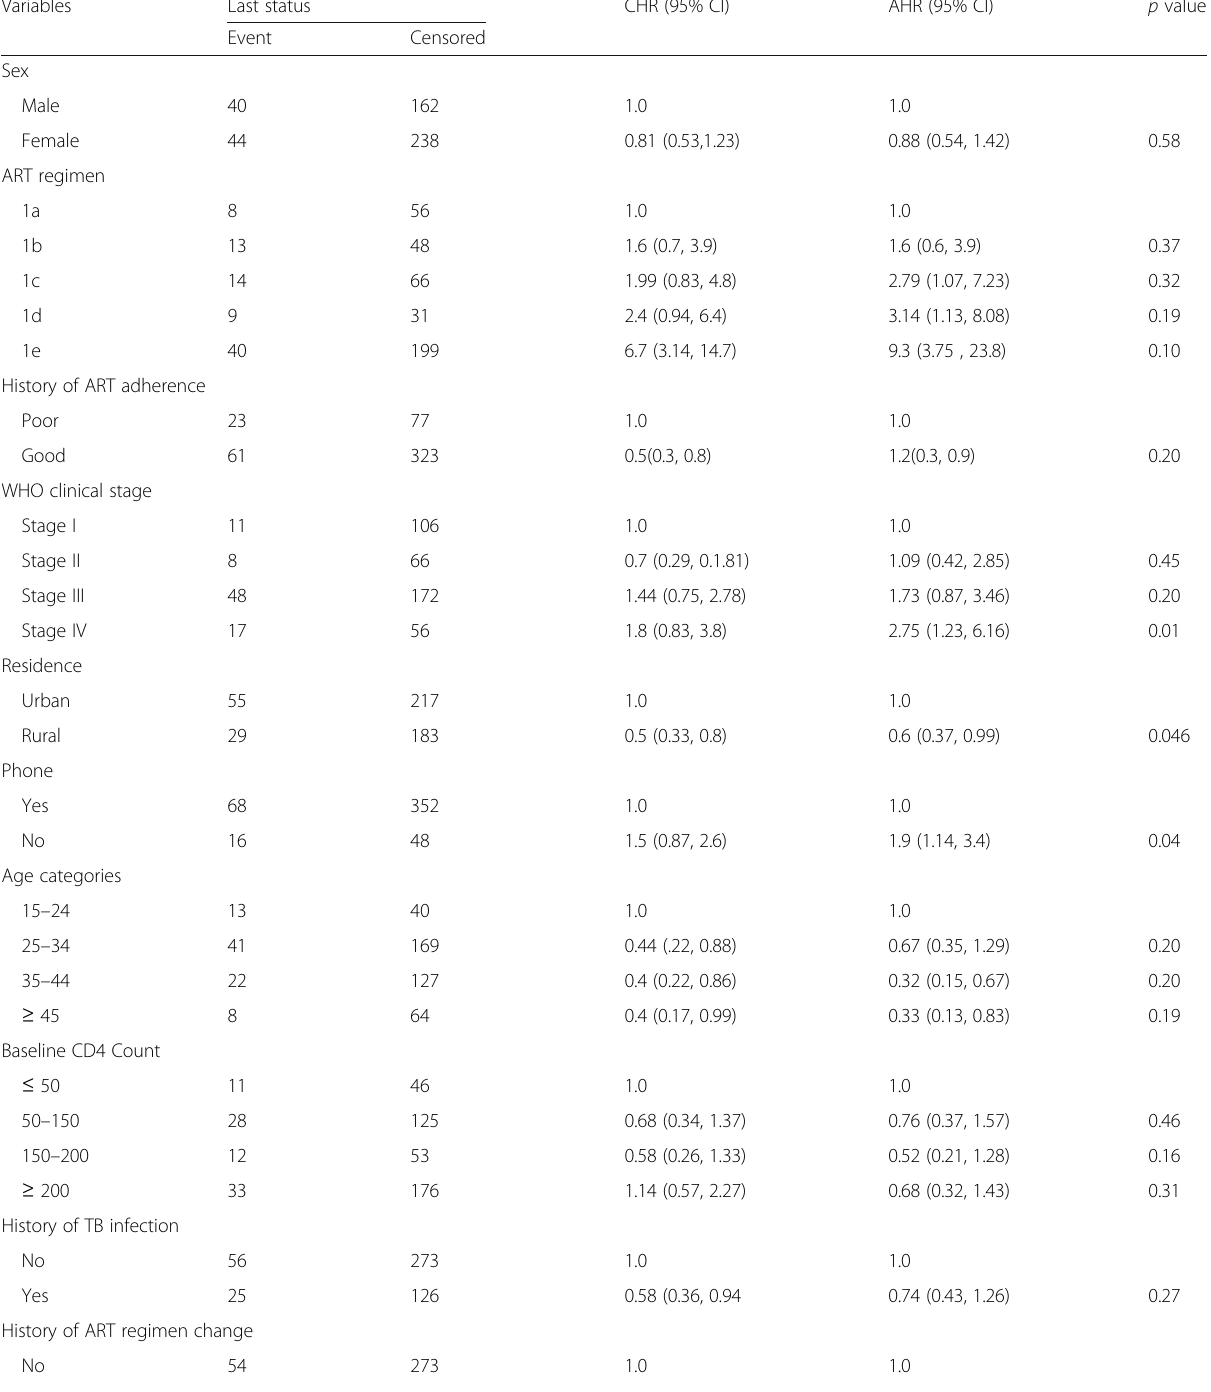
Table 4 Multivariable Cox regression analysis of predictors of LTFU among HIV-positive adult subjects on ART at Debre Markos Referral Hospital, North West Ethiopia, from January 30, 2008, to January 26,